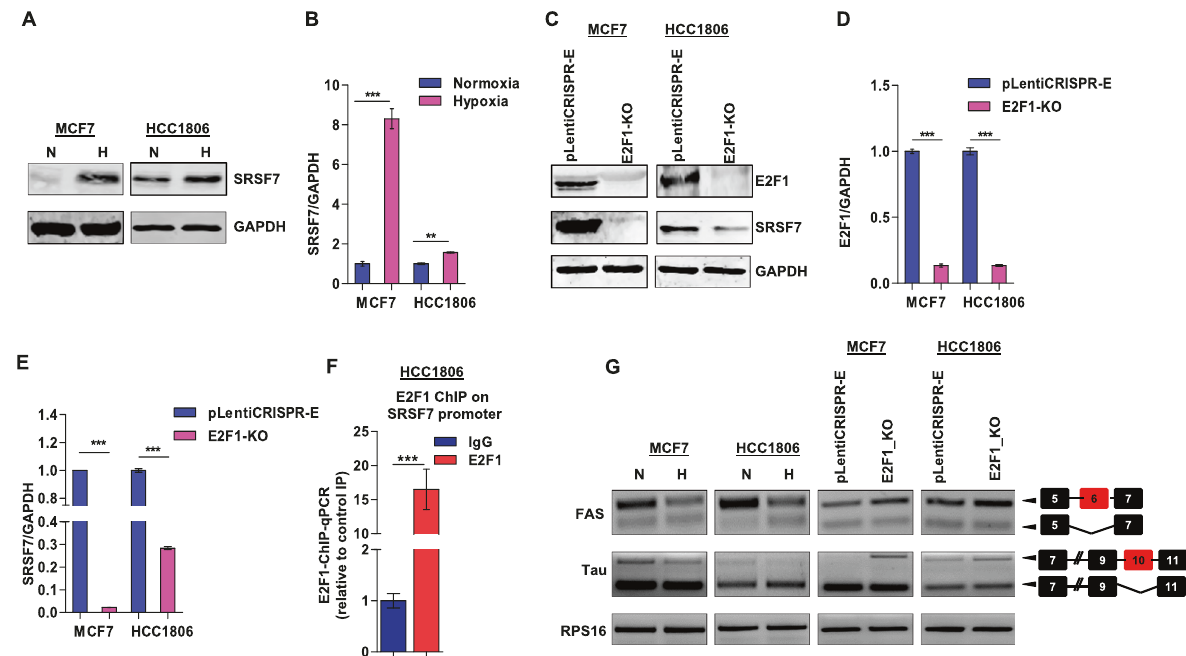
Fig. 5 E2F1 alters the cancer spliceome by inducing splicing factor SRSF7 expression in hypoxic breast cancer cells. A Immunoblots of SRSF7 in MCF7 and HCC1806 cells (Normoxia versus Hypoxia). B Densitometric analysis of representative blots. C Immunoblots for E2F1 and SRSF7 in E2F1 knockout MCF7 and HCC1806 cells under hypoxia. D , E Densitometric analysis of representative blots. F ChIP qRT-PCR on SRSF7 promoter using E2F1 antibody in HCC1806 cells under hypoxia. Fold enrichment (E2F1/IgG) was normalized to 5% input. G Semi-quantitative PCR of FAS and Tau genes after 48 h of hypoxic treatment and E2F1 knockout under hypoxia in MCF7 and HCC1806 cells (RPS16 used as a control). * *P < 0.01 and ** *P <